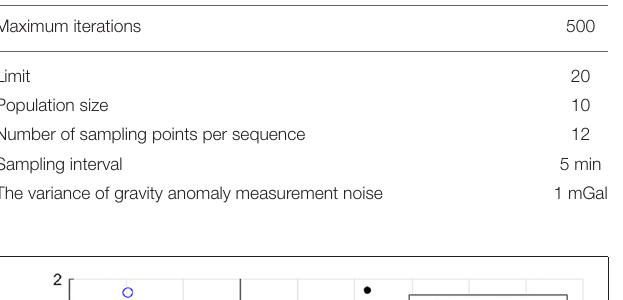
FIGURE 3 | The INS-indicated segment angle error. TABLE 3 | Configuration of the proposed algorithm.